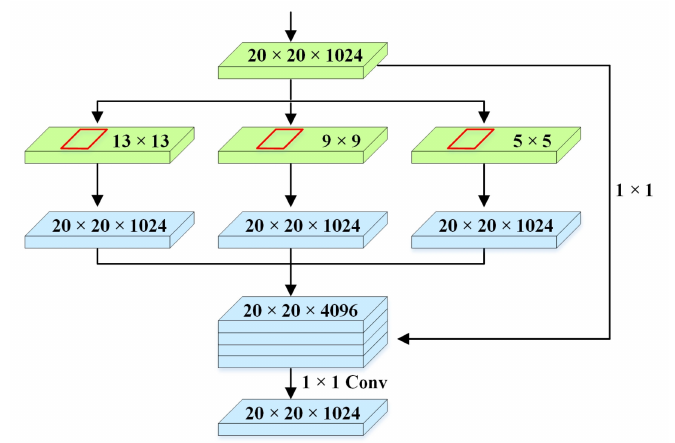
Figure A3. The structure diagram of